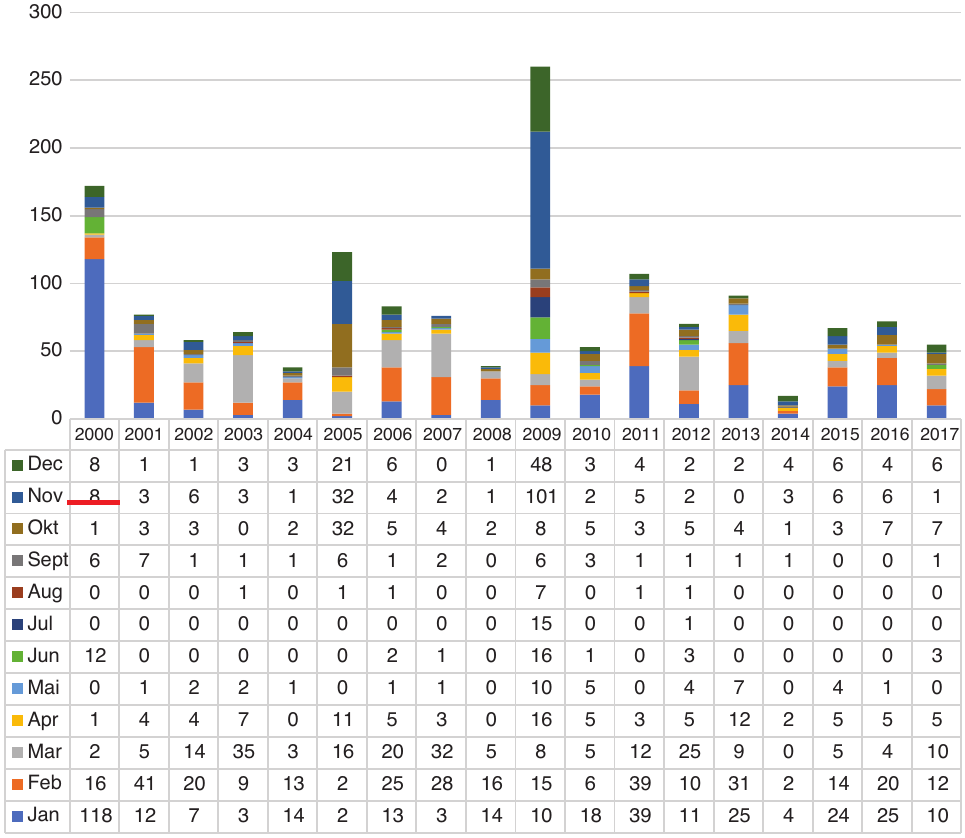
Figure 4. Media agenda –